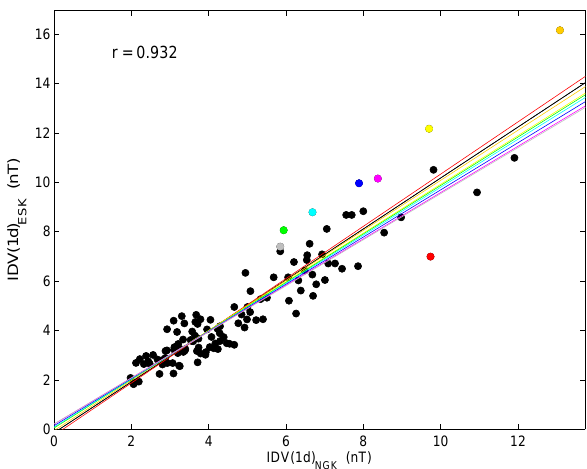
Fig. 9. Scatter plot of Bartels rotation means of IDV(1d) values from Niemegk and Eskdalemuir for 1911–1920, IDV(1d) NGK and IDV(1d) ESK respectively, shown using the same format as Fig. 3. The regression was considered not greatly influenced by outliers, and the plot residuals rendered homoskedastic and normally dis- tributed after N r = 8 outliers were removed out of the total of 123 data points. The correlation coefficient prior to outlier removals was r = 0 . 932.